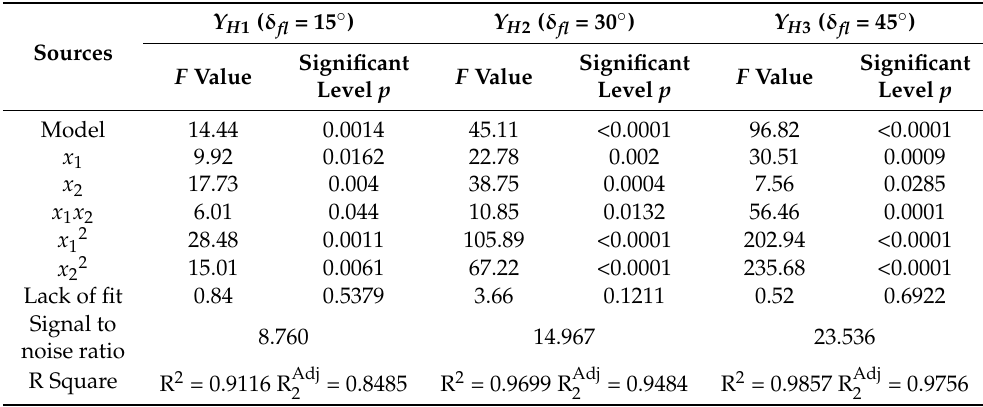
Table 3. Variance analysis for the regression model of comprehensive evaluation